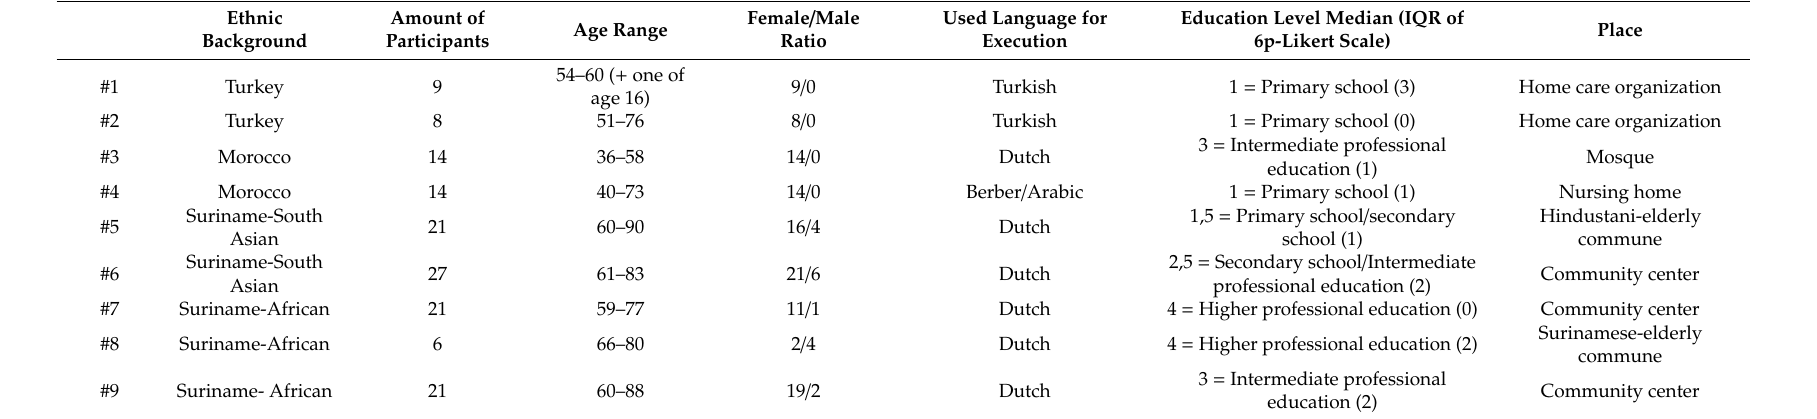
Table 3. Characteristics of the educational